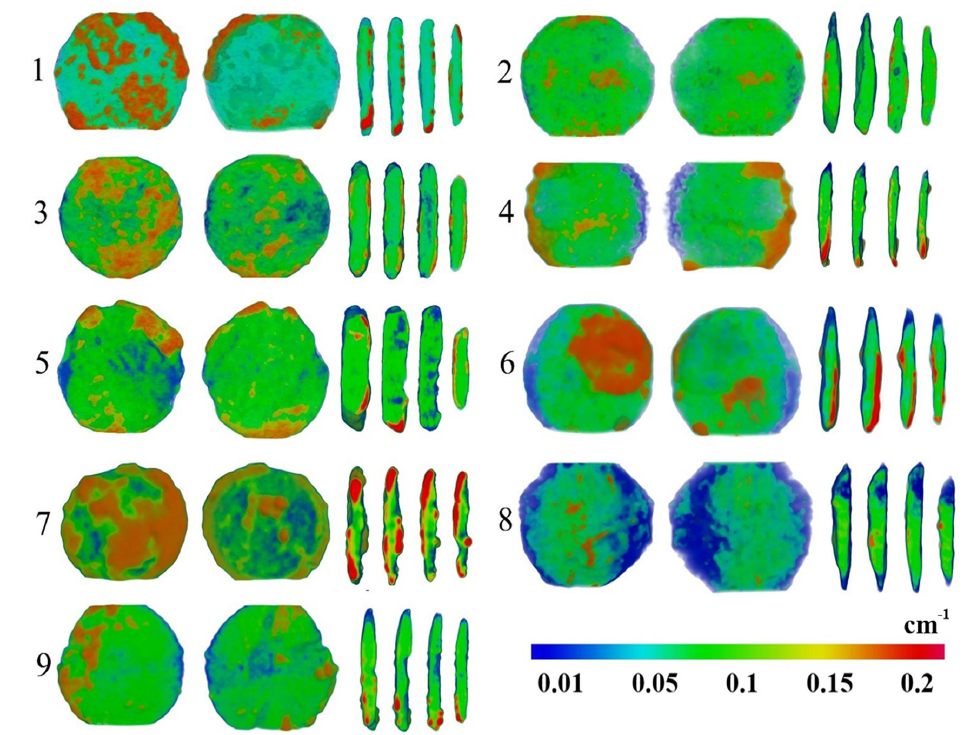
Figure 3. The 3D models after tomographic reconstruction and several transversal slices of the 3D models of the coins. The rainbow-like scale of neutron attenuation coefficients is shown. The regions with lower neutron attenuation coefficient can be attributed to copper–tin alloy areas, while the areas corresponding to high neutron attenuation coefficients are assumed to be corrosive contamination and patina materials. The dimensions of the reconstructed models correspond to the sizes of the coins shown in Table 1.